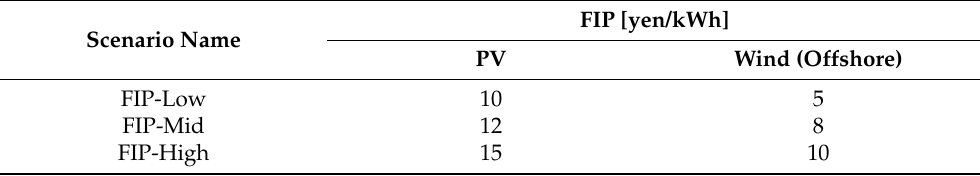
Table 6. Scenarios of